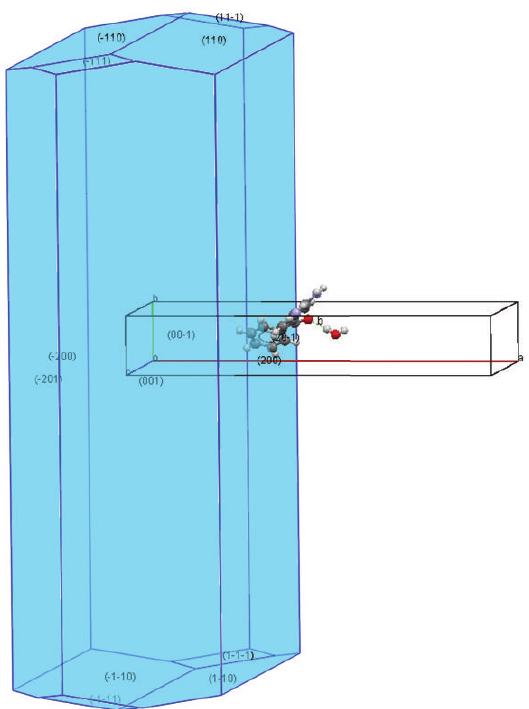
Figure 6: Predicted morphology of 2C 13 H 12 N 2 O ⋅ H 2 O. Growth shape from BFDH rules.